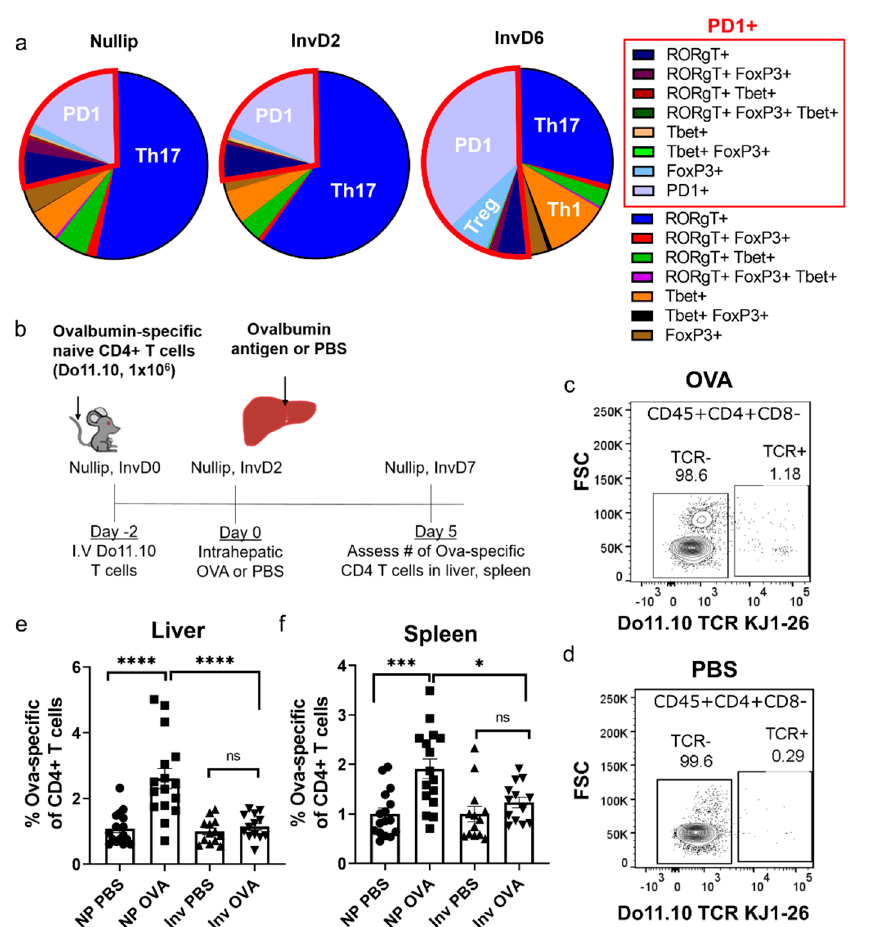
Figure 5. CD4+ T cell polarization is reproductive stage dependent with implications for antigen- specific activation. ( a ) Flow cytometry phenotyping of CD45+ CD4+ T cells from livers of mice at nullip, InvD2, and InvD6 reproductive stages (nullip n = 8, InvD2 n = 5, InvD6 n = 6). Only CD45+ CD4+ T cells that expressed at least one of the four phenotyping markers RORgT, Tbet, PD1, or FoxP3 are shown (see Figure S3 for total CD45+CD4+ T cell polarization); ( b ) Experimental schema for the in vivo T cell activation assay (Figure S4 shows transferred CD4+ Do11.10 cells); Representative flow cytometry plots showing expression of ova-specific Do11.10 T cell receptor (TCR) in CD45+ CD4+ CD8- cells from mice intra-hepatically injected with ( c ) ovalbumin (OVA) antigen or ( d ) PBS; Flow cytometry quantification of ova-specific CD4+ T cells (Do11.10 TCR+) as %CD4+ in ( e ) whole liver or ( f ) spleen across 2 independent experiments (nullip PBS n = 16, nullip OVA n =15, InvD2 PBS n = 13, InvD2 OVA n = 13). Data normalized to PBS average for reproductive group, One-way ANOVA. * p < 0.05, *** p < 0.001, **** p <